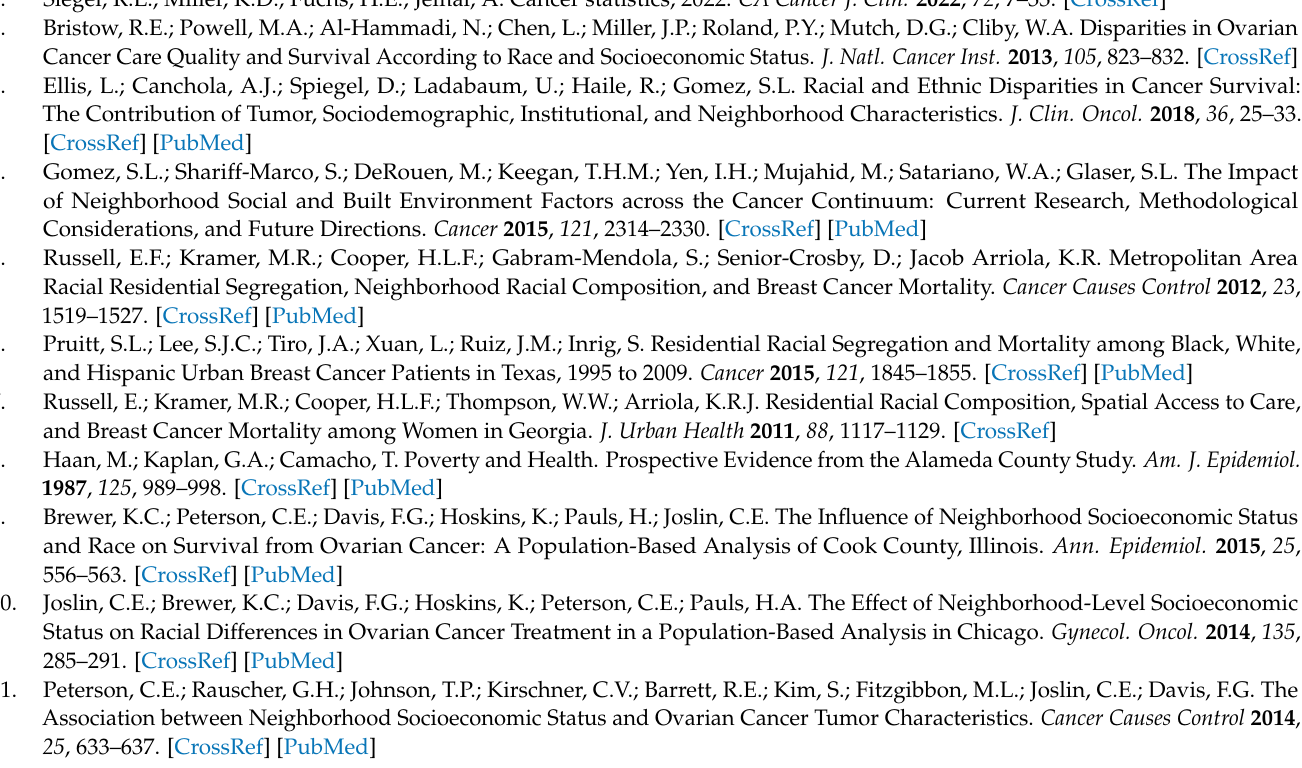
Figure S2: Results of the PCA; Figure S3: Distribution of the variables related to demography in the four clusters; Figure S4: Distribution of the variables related to housing in the four clusters; Figure S5: Distribution of the variables related to smoking in the four clusters; Figure S6: Distribution of the variables related to mobility in the four clusters; Figure S7: Distribution of metastasis combination by